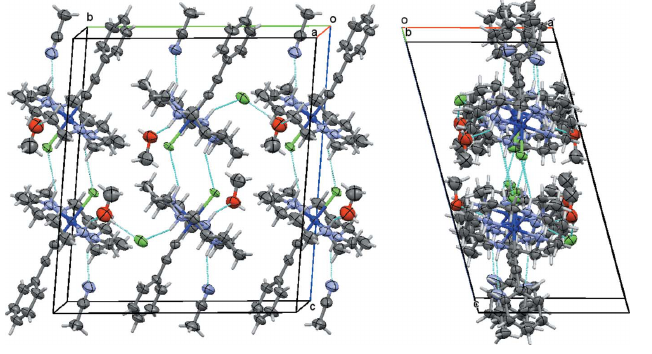
Figure 8 Hydrogen-bonding interactions in 2 , showing both layers connected by N—H (cid:2)(cid:2)(cid:2) O, N—H (cid:2)(cid:2)(cid:2) F hydrogen bonds. The top layer contains cations and anions of Co1 and S1, respectively, the bottom layer those of Co2 and S2. Hydrogen bonds are shown as dashed turquoise lines. Disorder of one of the trifluoromethanesulfonate anions and methylene chloride is omitted for clarity. View is down the a -axis direction.